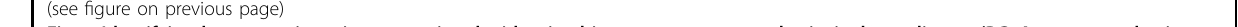
Fig. 1 Identifying host genetic variants associated with microbiome enterotypes and principal coordinates (PCoAs, computed using Bray – Curtis dissimilarity). a The enterotype plot of 618 individuals in discovery cohort. Two clusters were shown with red dots representing Bacteroides -dominated enterotype (440 individuals) and blue dots representing Prevotella -dominated enterotype (178 individuals). The fi rst two principal components (PCoA1 and PCoA2) are shown, with the amount of variation explained are reported for each axe. b The enterotype plot of 663 individuals in replication cohort. Two clusters were shown with red dots representing Bacteroides -dominated enterotype (473 individuals) and blue dots representing Prevotella -dominated enterotype (190 individuals). c The minor allele G of SNP rs13045408 at BTBD3-LINC01722 were positively correlated with Bacteroides abundance and negatively correlated with Prevotella abundance in discovery cohort. However, SNP rs1453213 at OXR1 had opposite effect effects to enterotypes compared with that of rs13045408. d rs13045408 and rs1453213 associated with “ Bacteroides - Prevotella ” enterotype in replication cohort ( PP-B = 0.061 and 0.024, respectively). e Manhattan plots of the host genetic variants associated with microbiome β -diversity (computed as Bray – Curtis dissimilarity matrix). The red line represents a genome-wide signi fi cant P value (5 × 10 – 8 ) and blue line represents suggestive P value (10 − 5 ). Five top loci were marked with gene name. f The replicated P value in this study for the 391 SNPs previously reported to be signi fi cantly associated with the microbiome. 12 SNPs are successfully replicated at P 1.7 × 10 − 4 = 0.05/296 (blue line), nine of which were most associated with Bacteroides stercoris